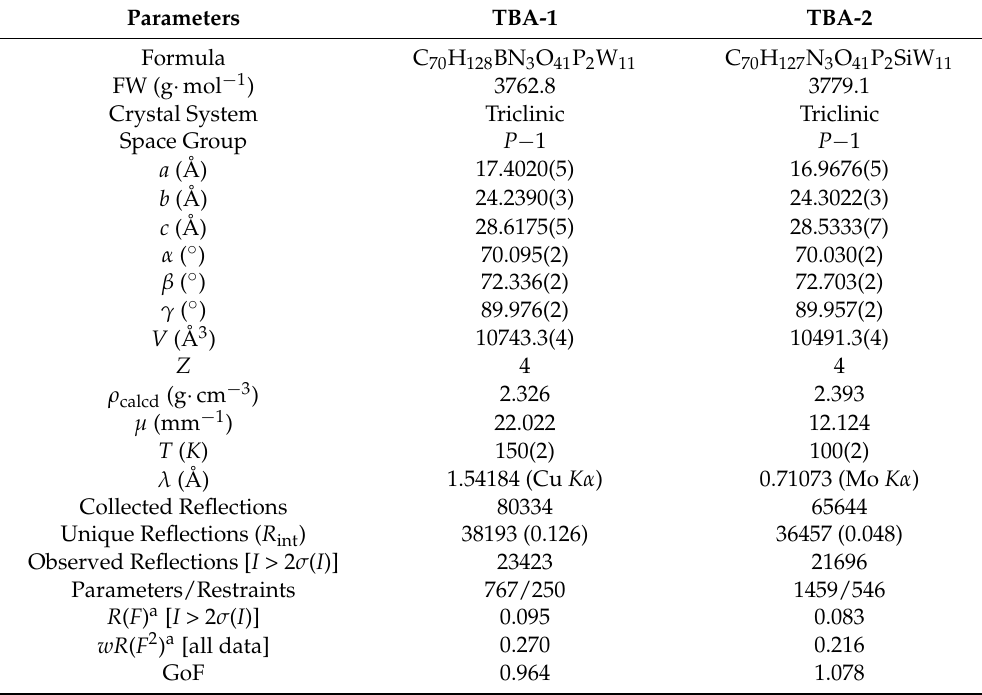
Table 2. Crystallographic data for TBA-1 and TBA-2